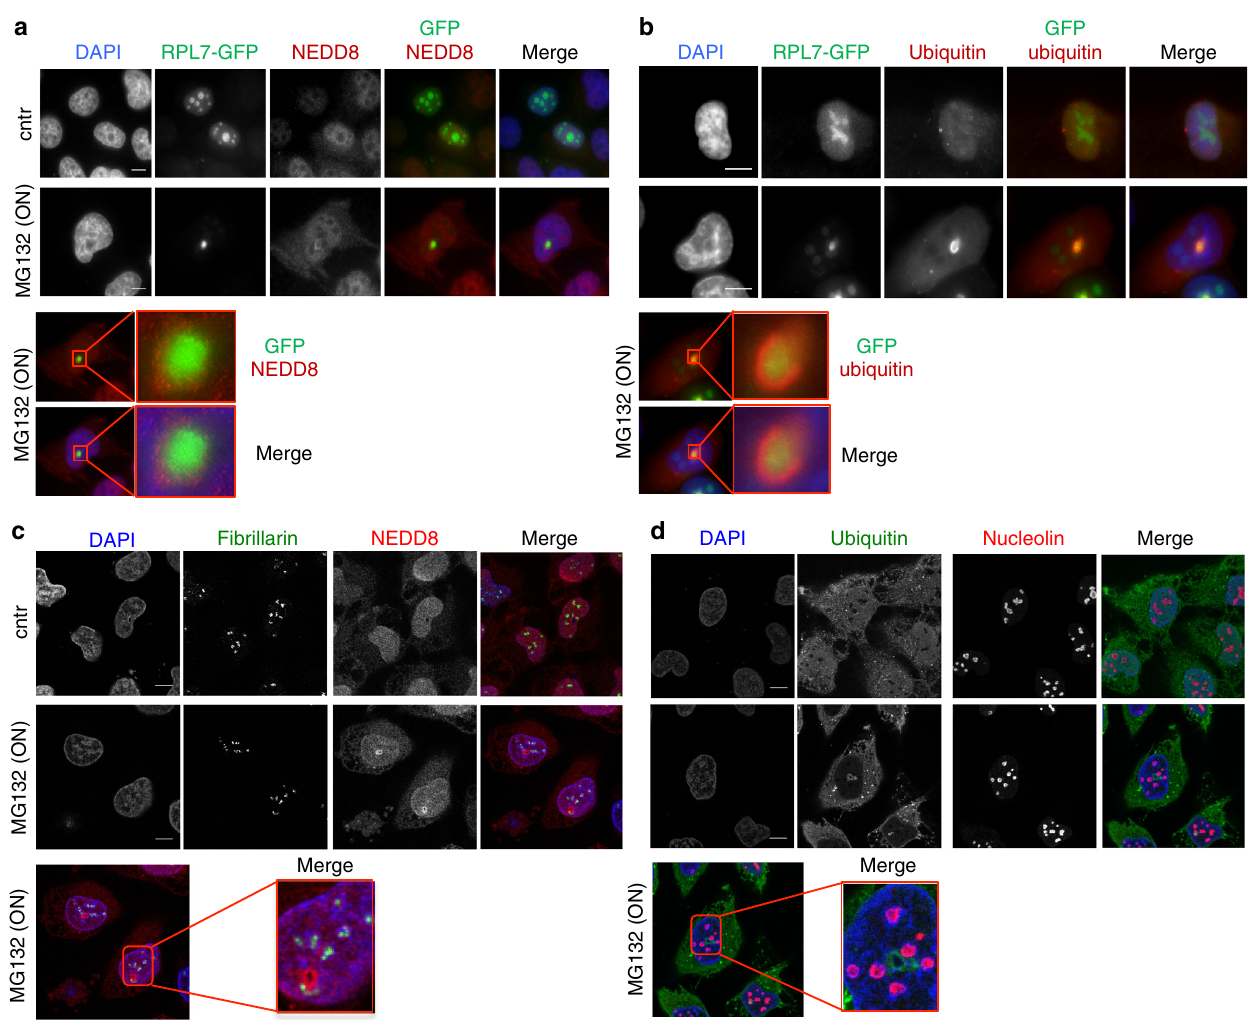
Fig. 5 RPL7 localises within the NEDD8/ubiquitin-stained aggregates. a , b H1299 cells were transfected with RPL7-GFP and 48 h later were treated or not with MG132 (5 µ M-ON) and stained for either NEDD8 ( a ) or ubiquitin ( b ) (red). Enlarged insets represent the NEDD8/ubiquitin-stained structures observed upon MG132 surrounding RPL7. c , d Experiment performed as above and cells were stained with fi brillarin and NEDD8 ( c ) or nucleolin and ubiquitin ( d ). Nuclei were stained with DAPI. Scale bars, 10 µ